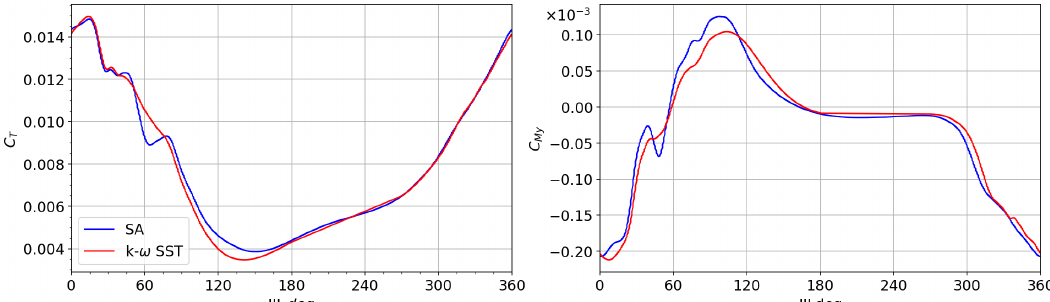
Figure 4. Comparison of thrust and pitching moment coefficients of the blade within one revolution by different turbulence models: Spalart–Allmaras (SA) and the k − ω SST turbulence